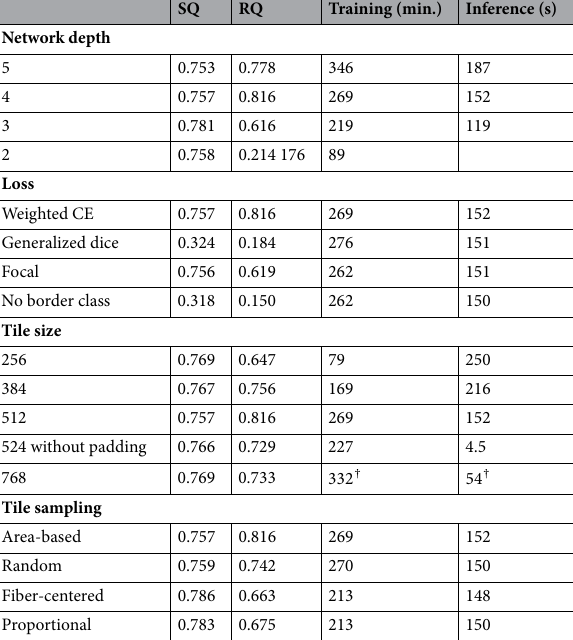
Table 2. Evaluation results for different choices of hyper-parameters, measured in terms of Segmentation Quality (SQ) and Recognition Quality (RQ) , with training and inference times. Inference times are measured on † image 18. CE denotes cross-entropy. Using a V100